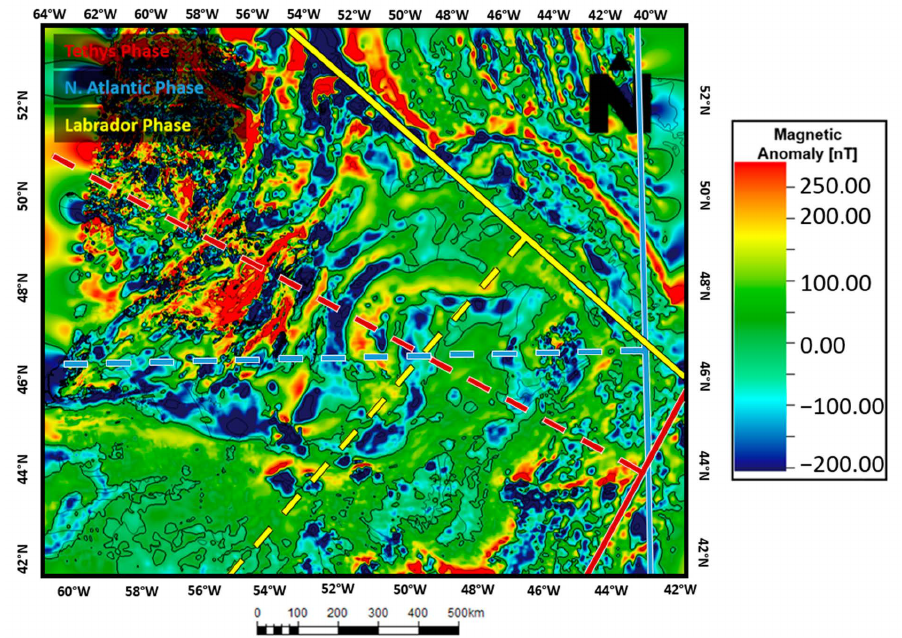
Figure 7. Overview of the magnetic anomaly signature of the continental margin of Eastern Canada centered on the Grand Banks, with successive rifting axes (solid lines) and orthogonal extension directions (dashed lines) superimposed. Magnetic data from GSC